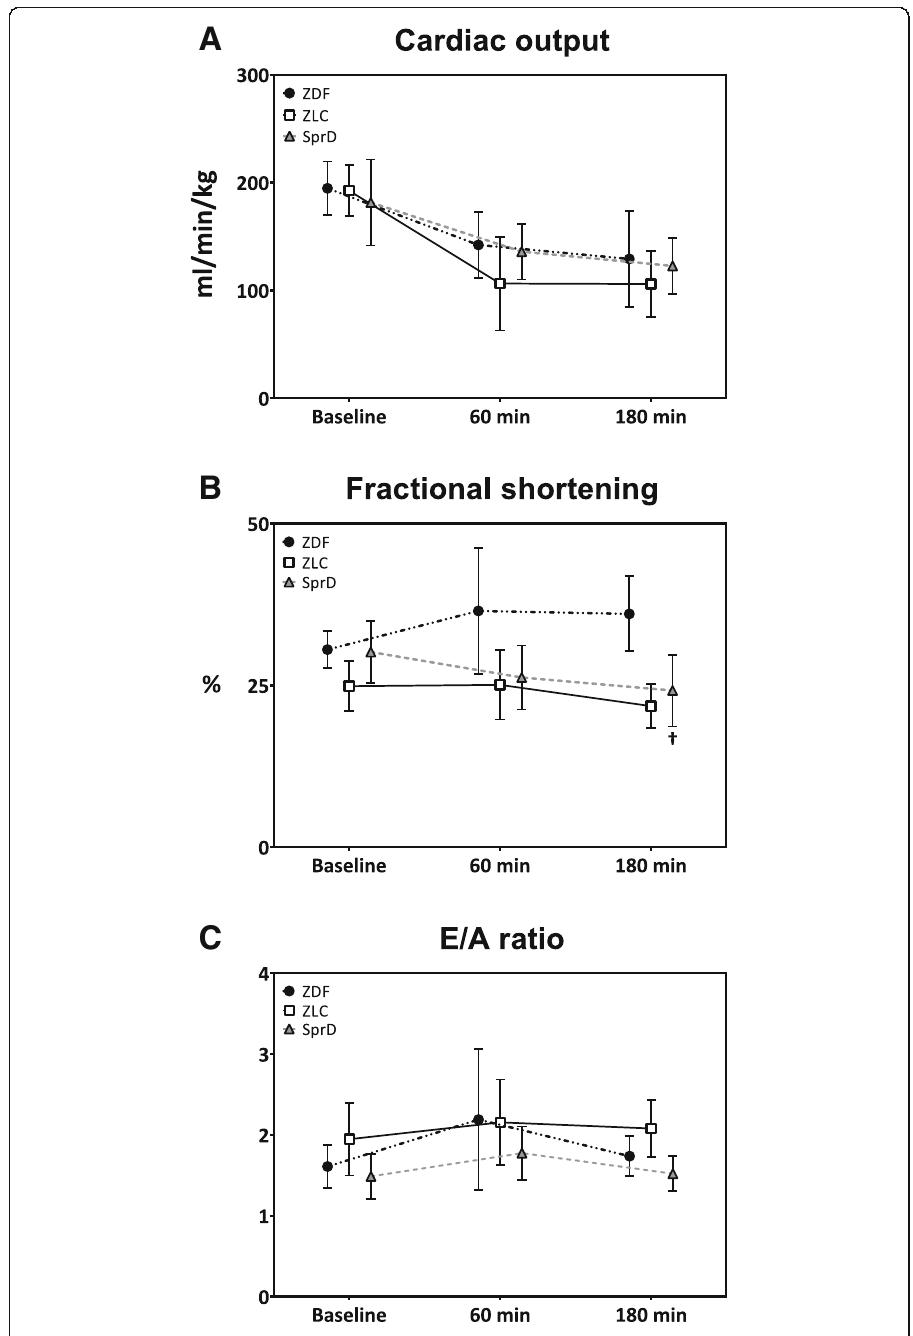
Fig. 3 Echocardiographic parameters of cardiac function. Data are presented as mean and SD. a Cardiac output standardized to animal weight. Number of animals at examination times: ZDF ( n = 13, 11, and 9), ZLC ( n = 10, 5, and 2), and SprD ( n = 8 at all examinations). b Fractional shortening; ZDF ( n = 11, 11, and 10), ZLC ( n = 14, 6, and 5), and SprD ( n = 8 at all examinations). c E/A ratio; ZDF ( n = 12, 10, and 8), ZLC ( n = 14, 5, and 4), and SprD ( n = 8,6, and 8). † p < 0.05 ZDF vs. SprD. ZDF: Zucker diabetic fatty group, ZLC: Zucker lean control group, SprD: Sprague Dawley with the ZLC group ( p < 0.05). No difference was seen at the end of the experiment. In the SprD group, sL-selectin was higher both at baseline ( p < 0.05) and 180 min after ROSC ( p < 0.05) compared with the ZDF group.